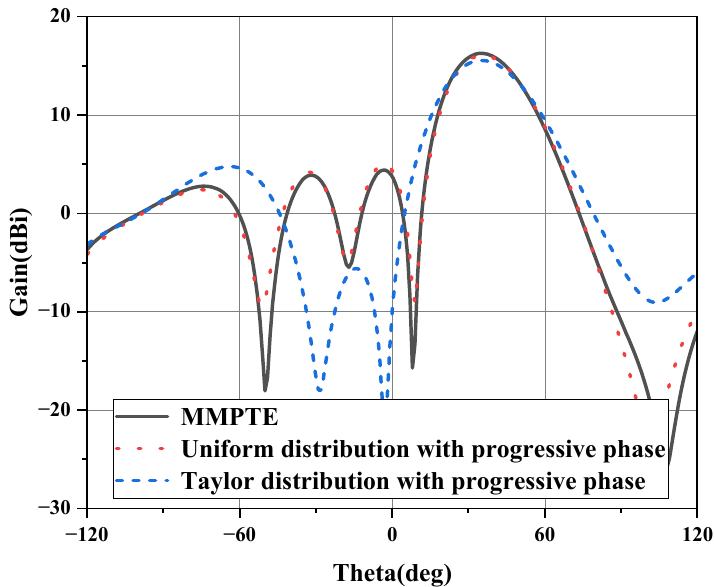
Figure 4. The comparison of radiation pattern with different excitation distributions at 94 GHz.